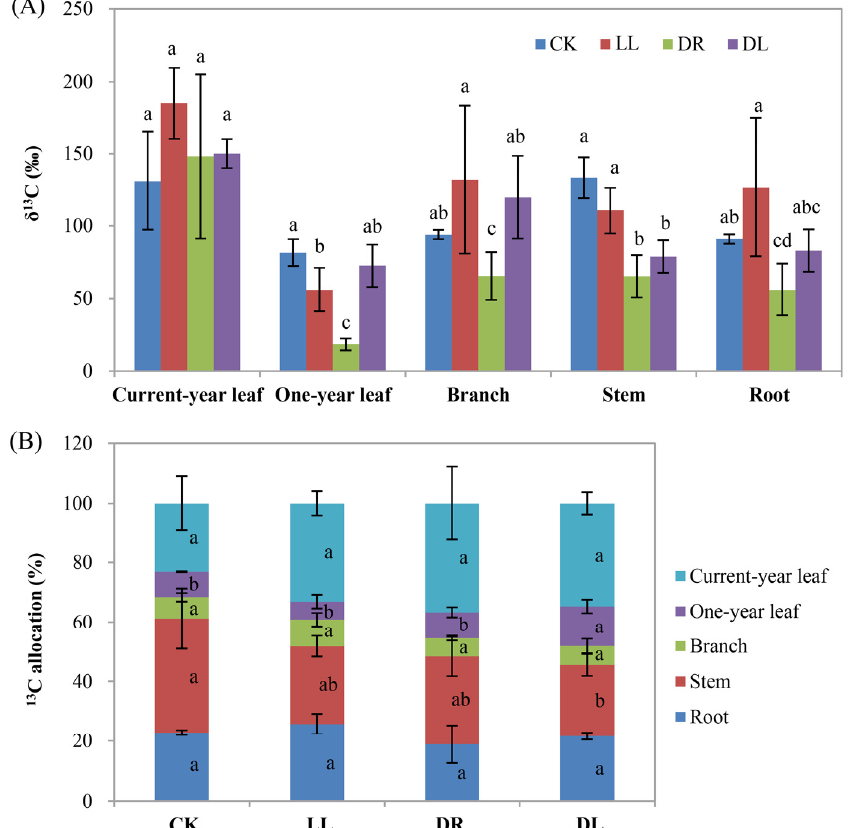
Figure 8. Effects of low light, drought, and their combined stress on carbon allocation in the different organs. ( A ) values of δ 13 C; ( B ) 13 C allocation. CK: control; LL: low light; DR: drought; and DL (DR + LL): the combined stress of drought and low light. Every treatment included three individual repeats; all the current-year leaves, one-year leaves, branches, stems, and roots were harvested for each repeat. Error bars represent means ± SE, and lowercase letters represent a significant difference of p < 0.05 in the same tissues among the treatments.